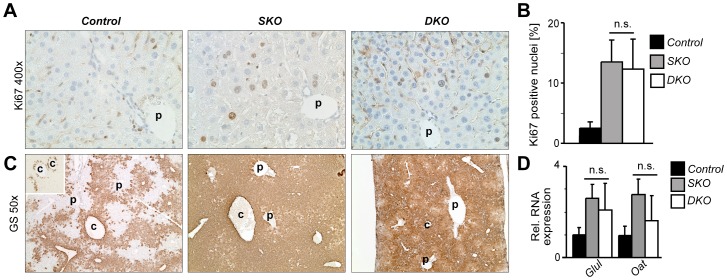
c-Jun is not essential for hepatocyte proliferation and liver zonation following Apc

loss. (A) Hepatocyte proliferation was analyzed at 6 days following Cre induction by immunohistochemistry for the proliferation marker Ki67. (p, portal vein). (B) The percentage of Ki67 positive hepatocytes is shown in [%] ± S.D. (n = 6–11 mice/genotype; n.s., not significant). (C) Immunohistochemistry for the β-Catenin target gene and zonation marker glutamine synthetase (GS) was performed in livers with the indicated genotypes. p, portal vein; c, central vein. (D) Hepatic expression of the indicated genes at 6 days following Cre induction was determined by qPCR and is given as relative expression compared to control livers (n = 5 livers/genotype).